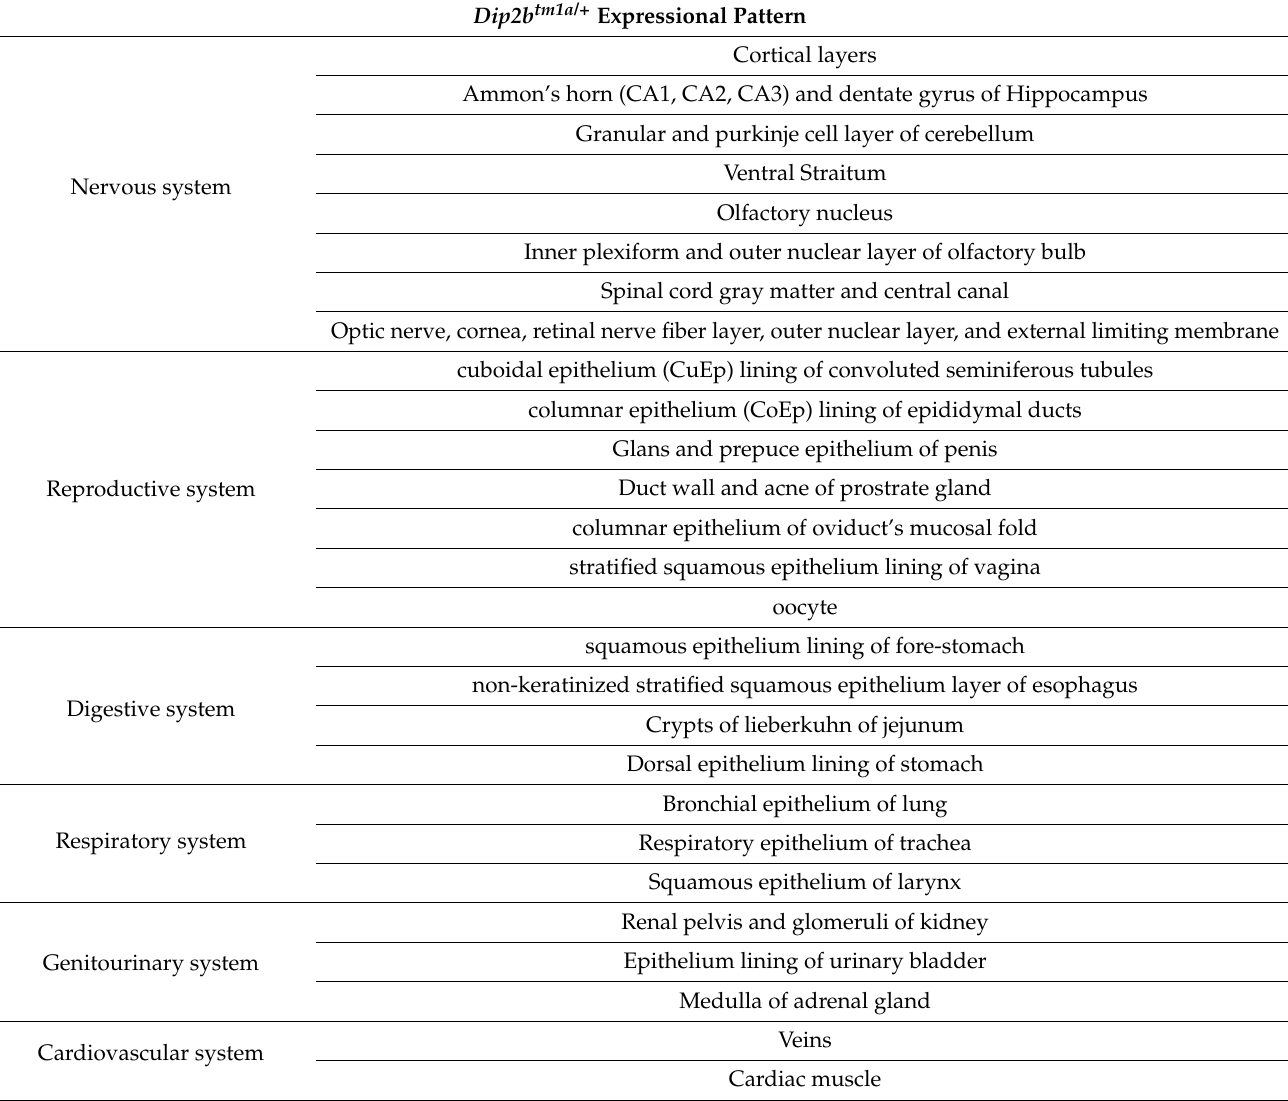
Table 1. Summary of expression pattern revealed by X-gal staining of Dip2b tm1a/+